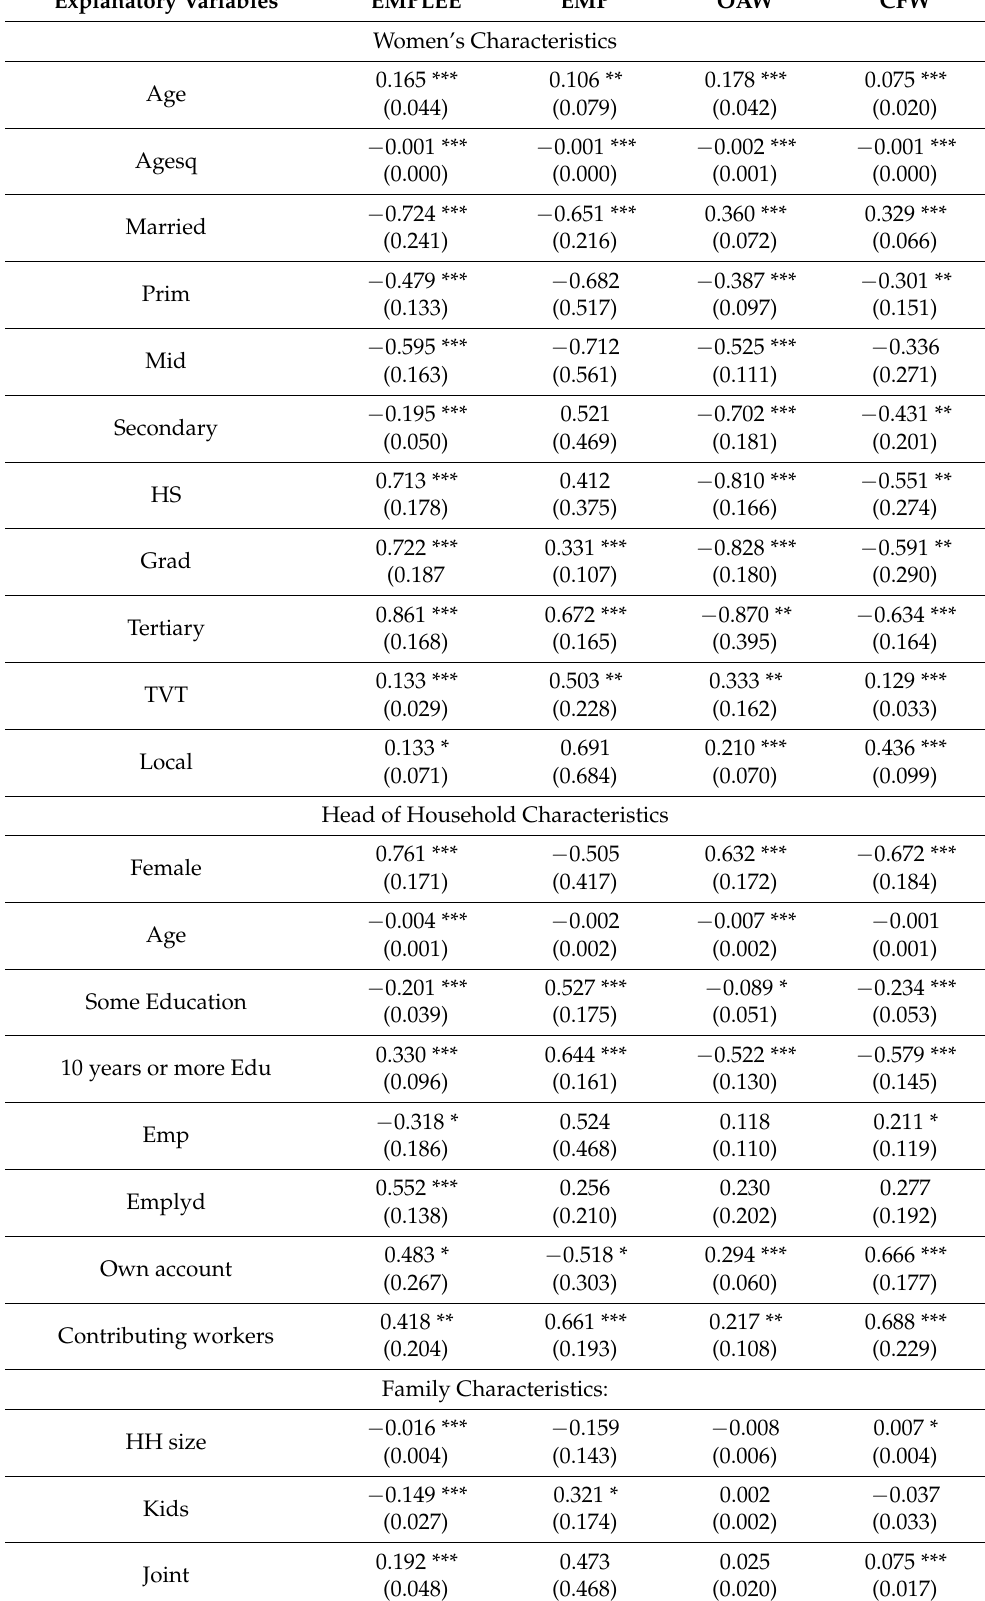
Table 3. Multinomial Logit estimates of the employment status of women aged 15 to